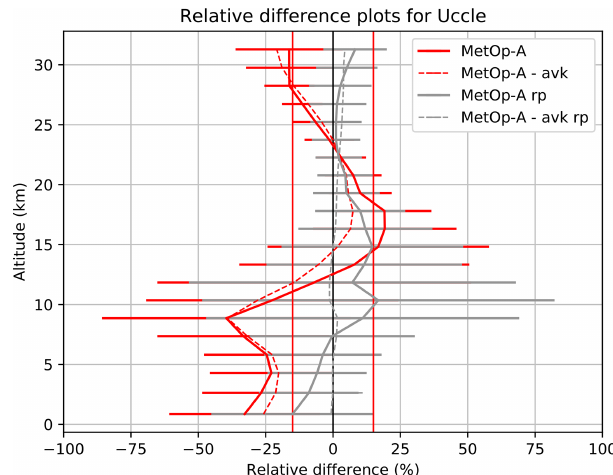
Figure 5. Relative mean differences and standard deviations be- tween ozone profiles retrieved from MetOp-A/GOME-2 and Uccle ozone profiles for the time period from January to December 2018. The red graph represents the mean differences when using the oper- ational MetOp-A/GOME-2 product, and the grey graph represents the mean differences when the UV sensor degradation correction has been applied in the MetOp-A/GOME-2 ozone retrieval. The rel- ative mean differences denoted by dashed lines are obtained after applying the averaging kernel to the Uccle sounding data. Finally, the thin red vertical lines mark the ± 15% target error range of the MetOp-A/GOME-2 ozone profile